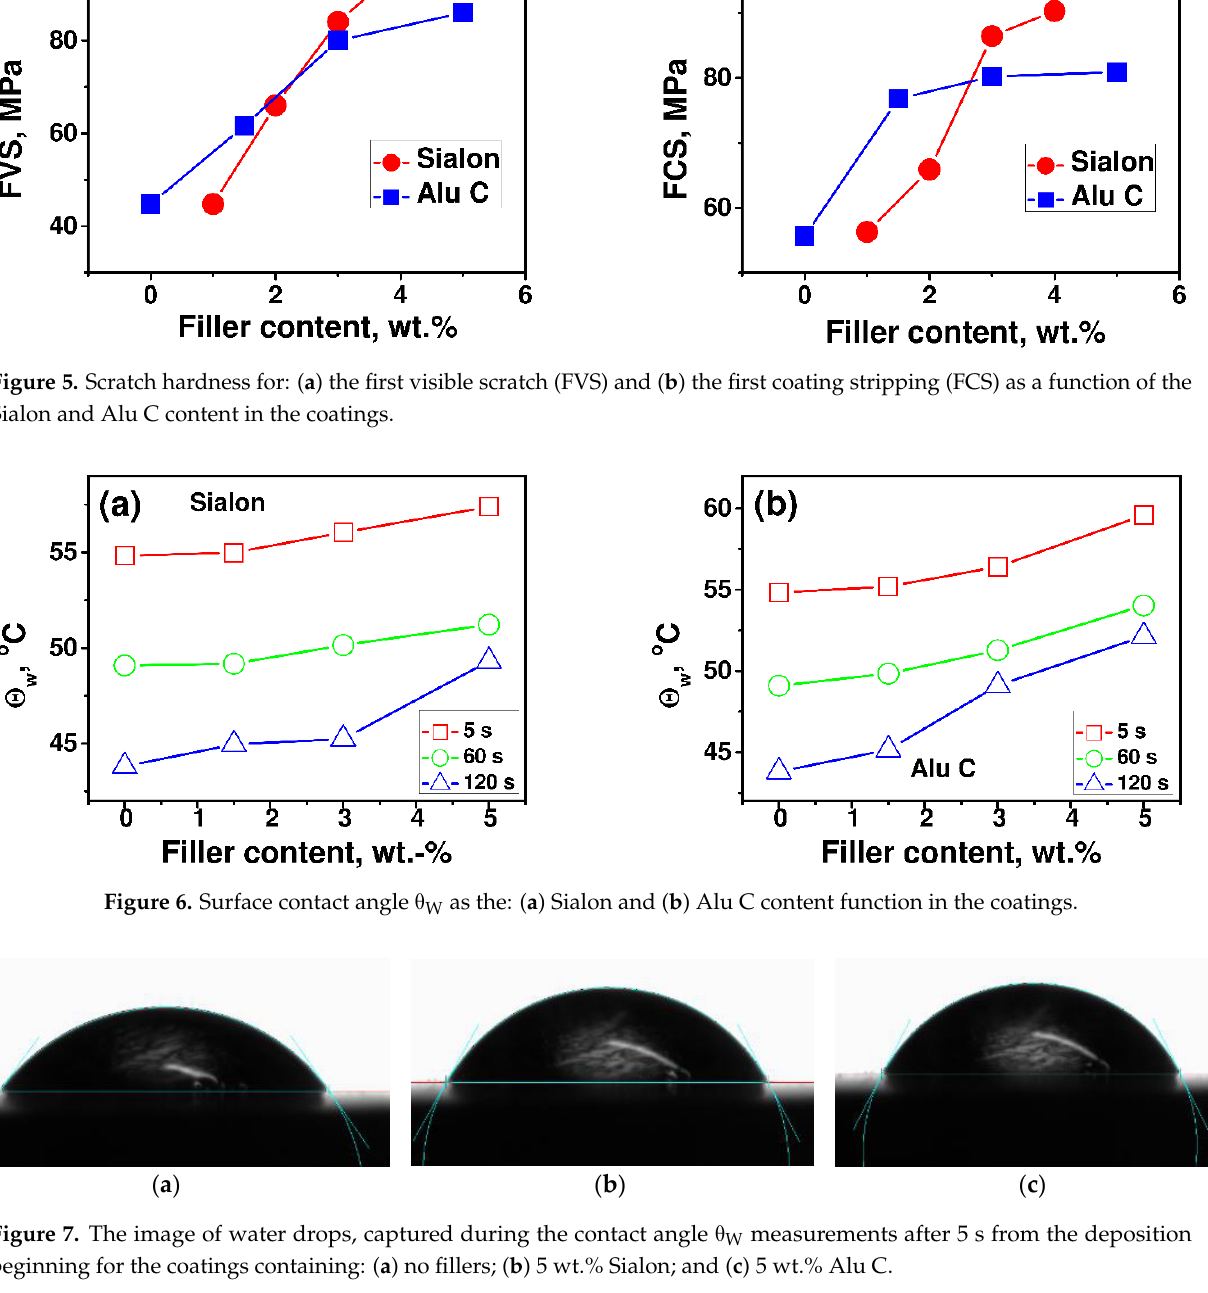
Figure 6. Surface contact angle Ɵ W as the: ( a ) Sialon and ( b ) Alu C content function in the coatings.